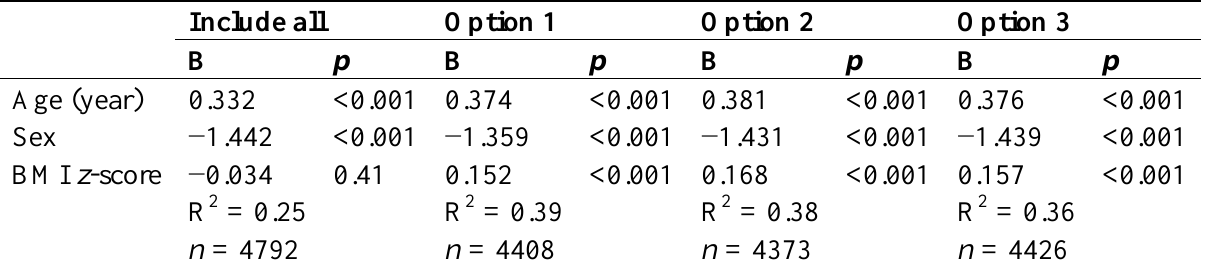
Table 2. Linear regression models showing variables associated with energy intake (MJ); including and excluding misreporters